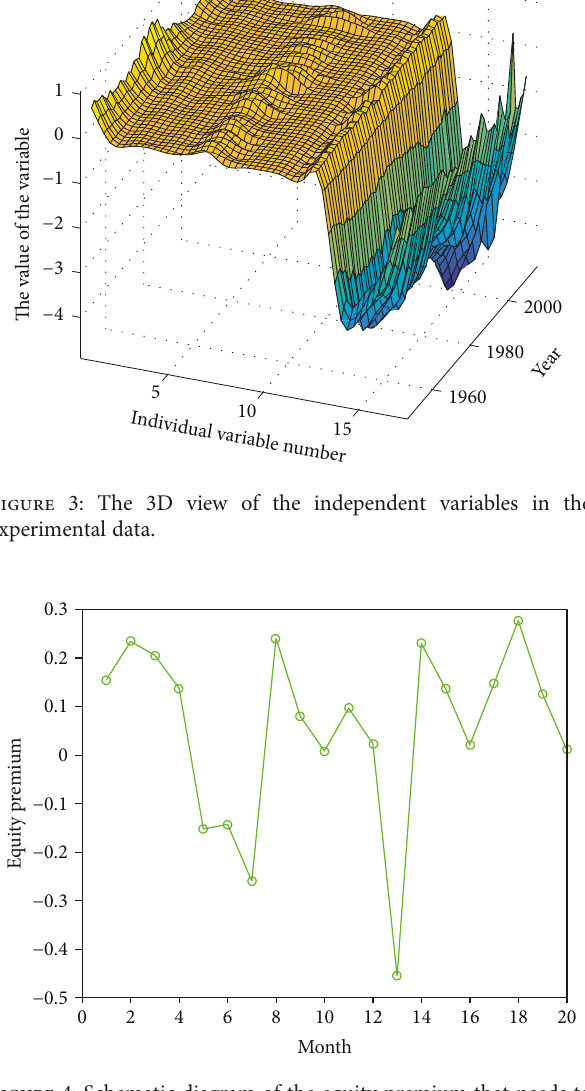
Figure 4: Schematic diagram of the equity premium that needs to be